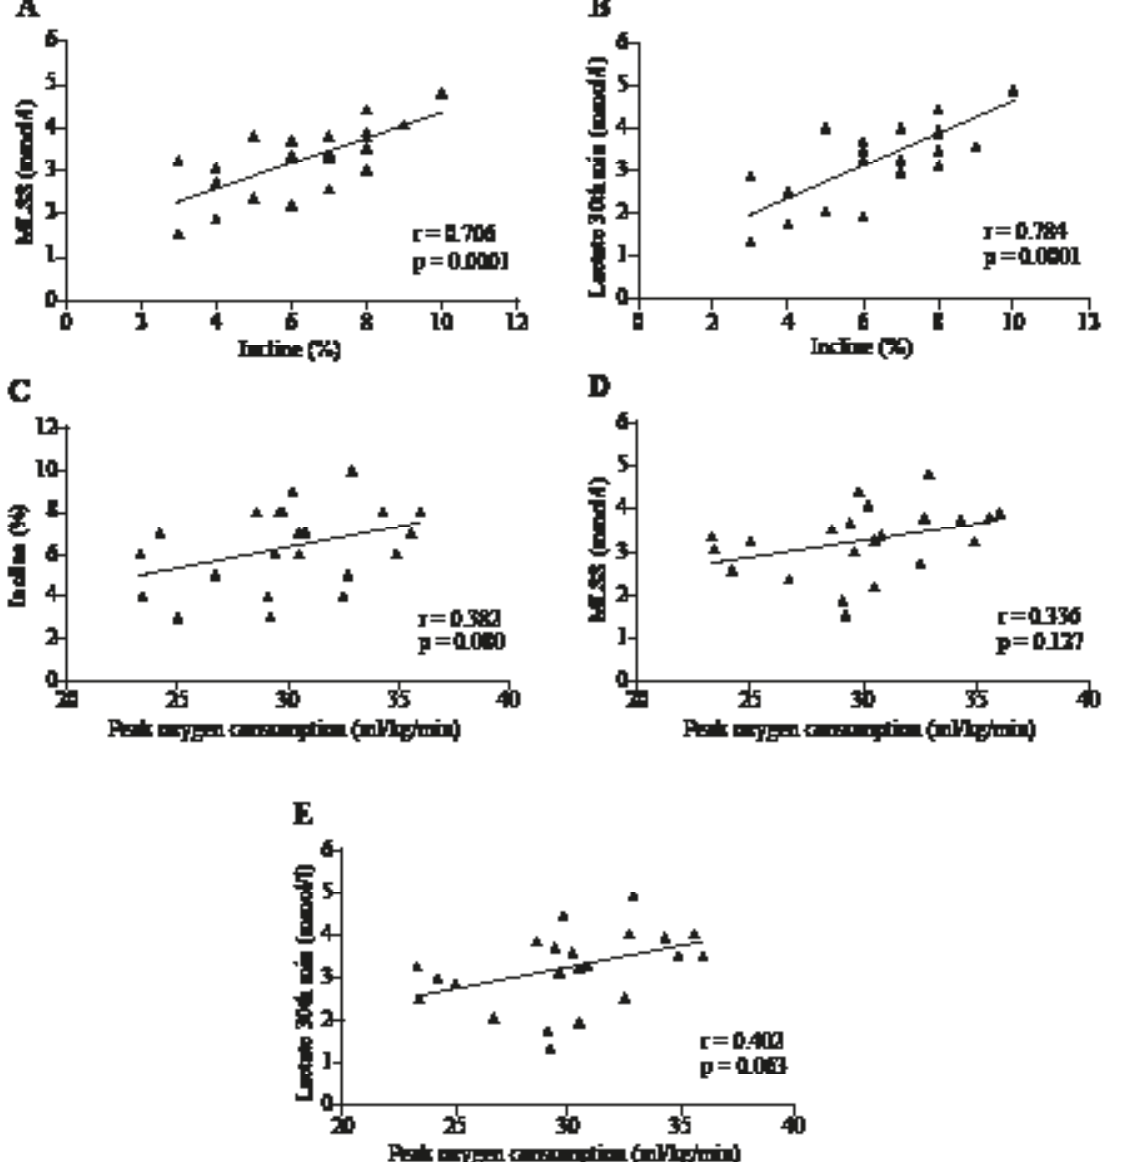
Figure 1 - Correlation between incline, peak oxygen consumption and lactate